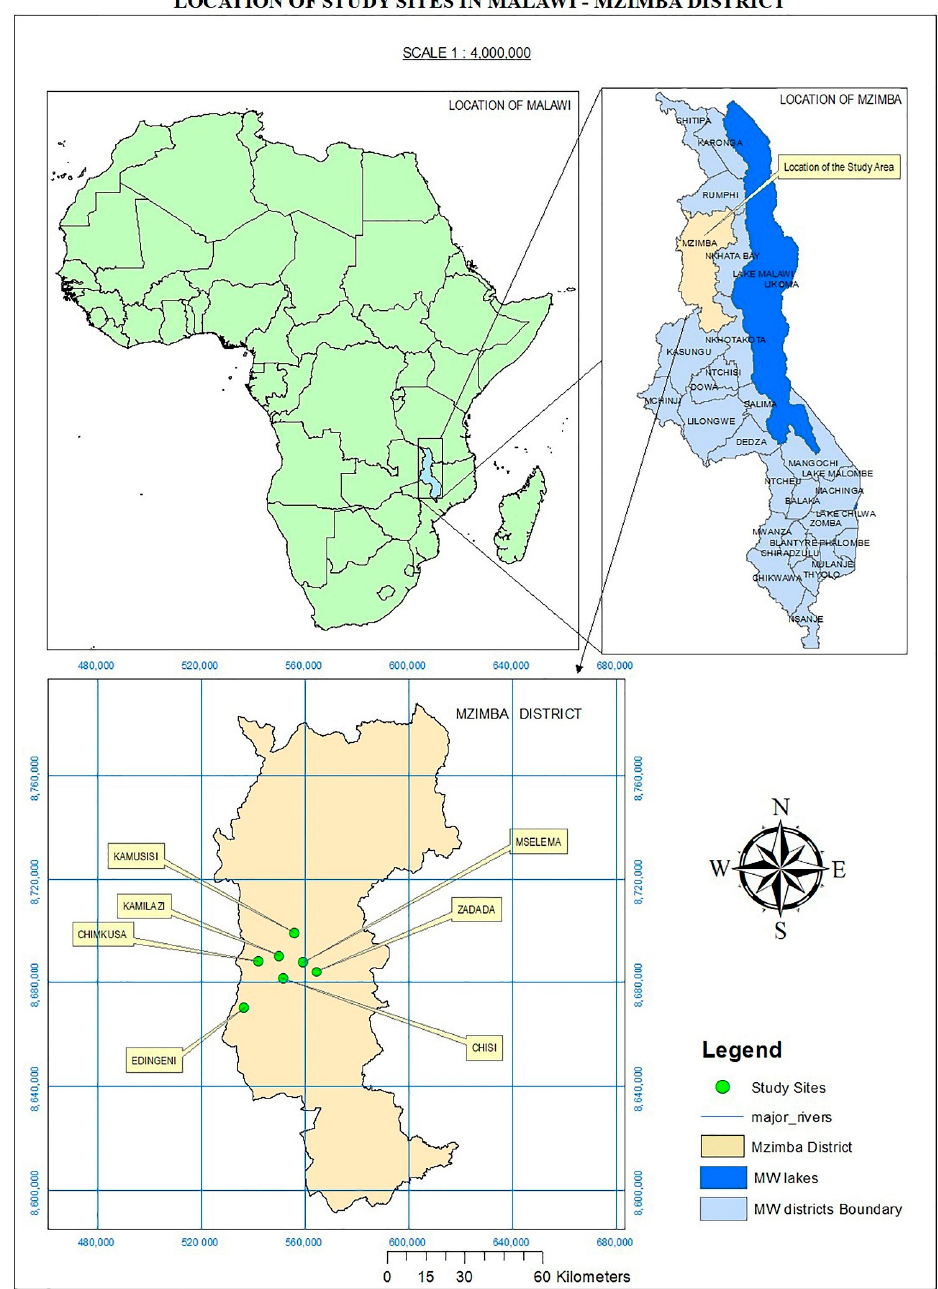
Figure 1. Maps showing study area and visited